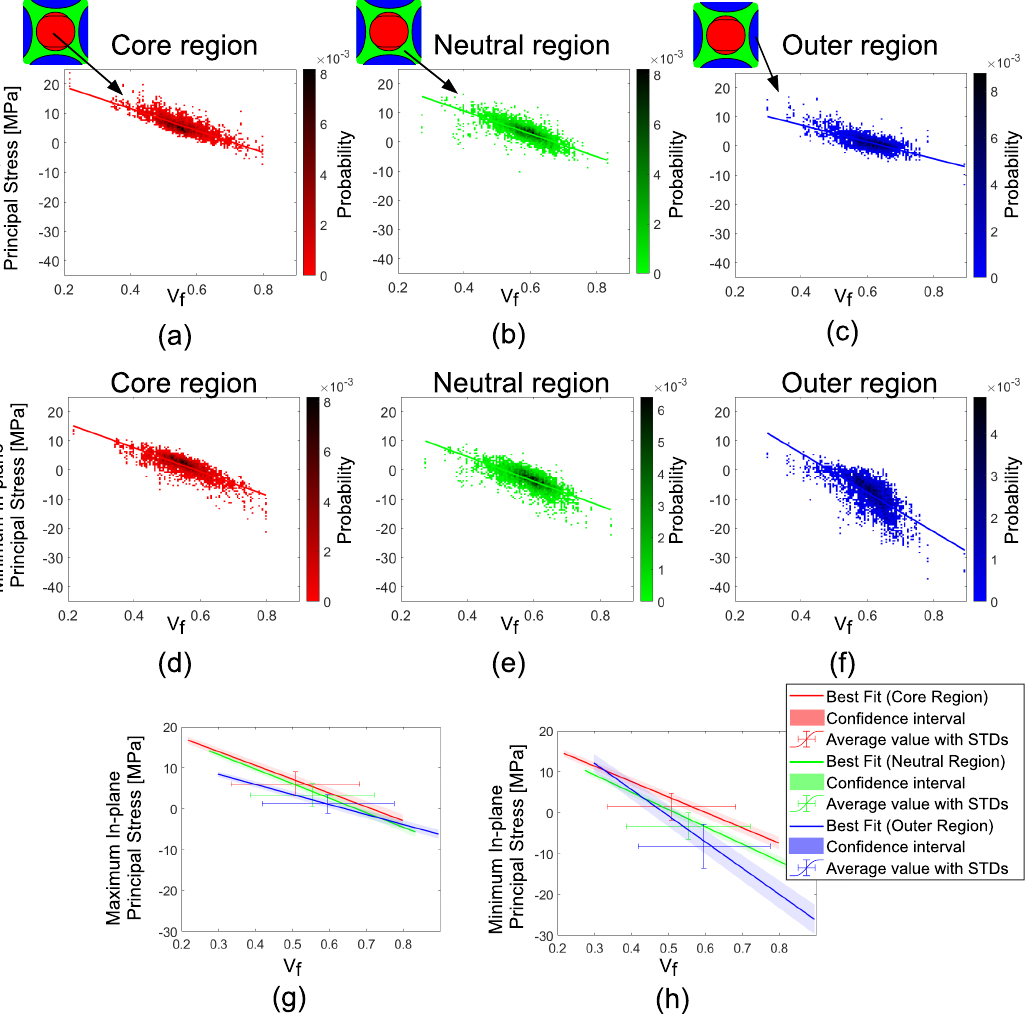
Figure 11. Maximum in-plane principal stresses vs. V f for the core ( a ), the neutral ( b ) and the outer regions ( c ). The minimum in-plane principal stresses vs. V f for the core ( d ), the neutral ( e ) and the outer regions ( f ). Best linear fits and confidence intervals of the maximum ( g ) and the minimum ( h ) in-plane principal